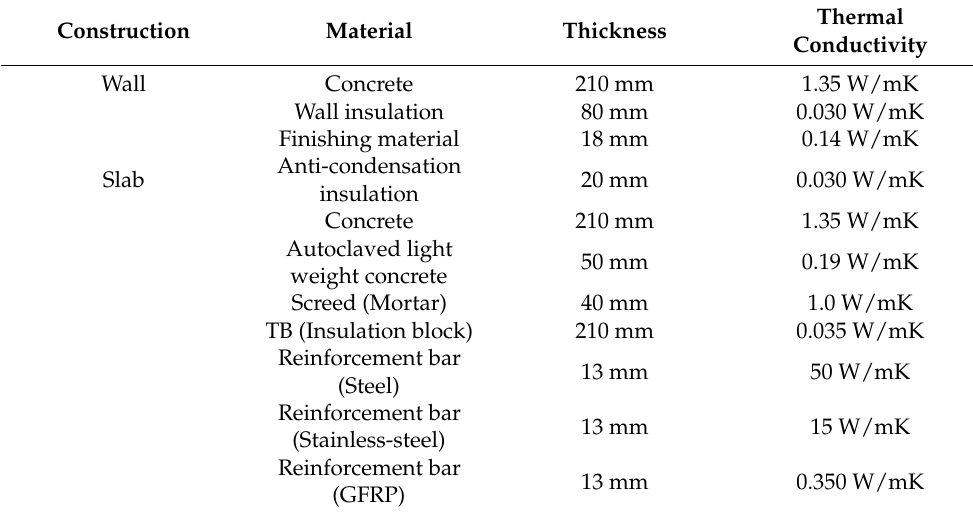
Table 2. Material properties of the external wall and balcony slab.